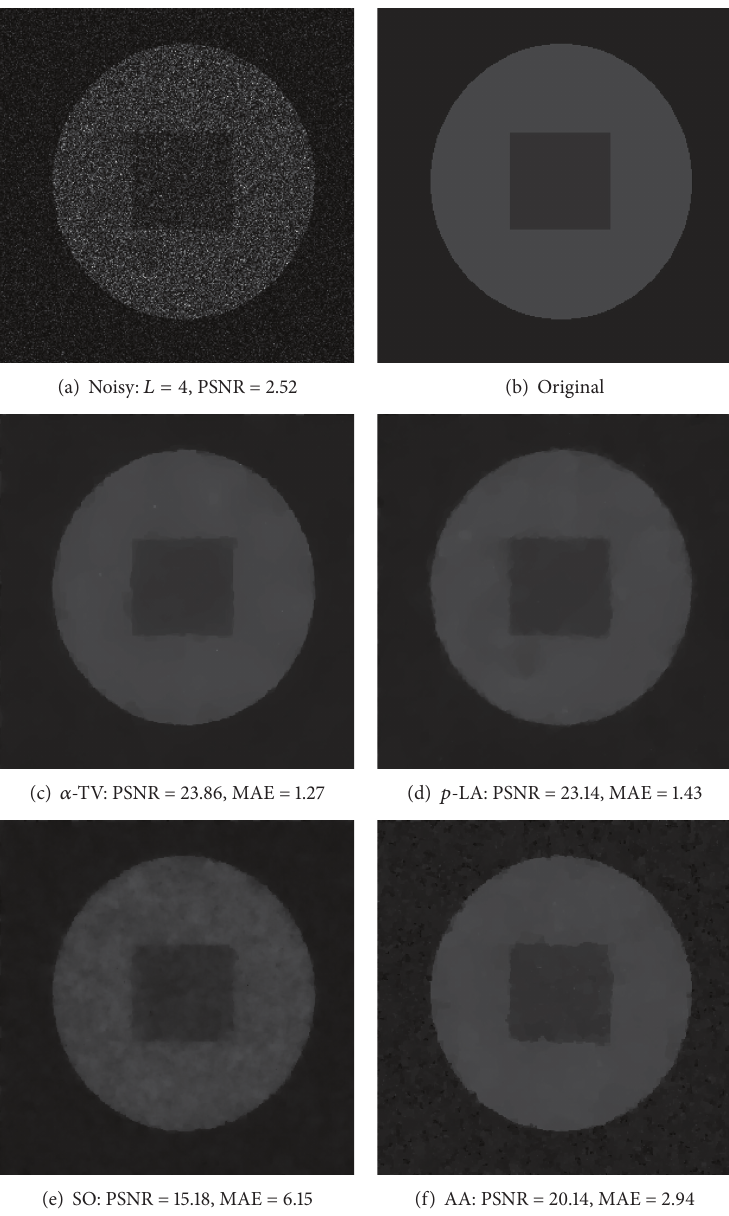
Figure 3: Synthetic image ( 300 × 300 ) (a) Noisy image corrupted by speckle noise for 𝐿 = 4 in (8). (b) Original image. (c) Our algorithm by = 1.3 . (e) SO algorithm, 𝜆 = 0.7 , 𝛼 = 0.25 . (f) AA algorithm, 𝜆 = 150 𝛼 -TV, 𝜎 = 2 , 𝑘 = 0.05 , 𝜏 = 0.05 . (d) Our algorithm by 𝑝 -LA, 𝑝 𝑈